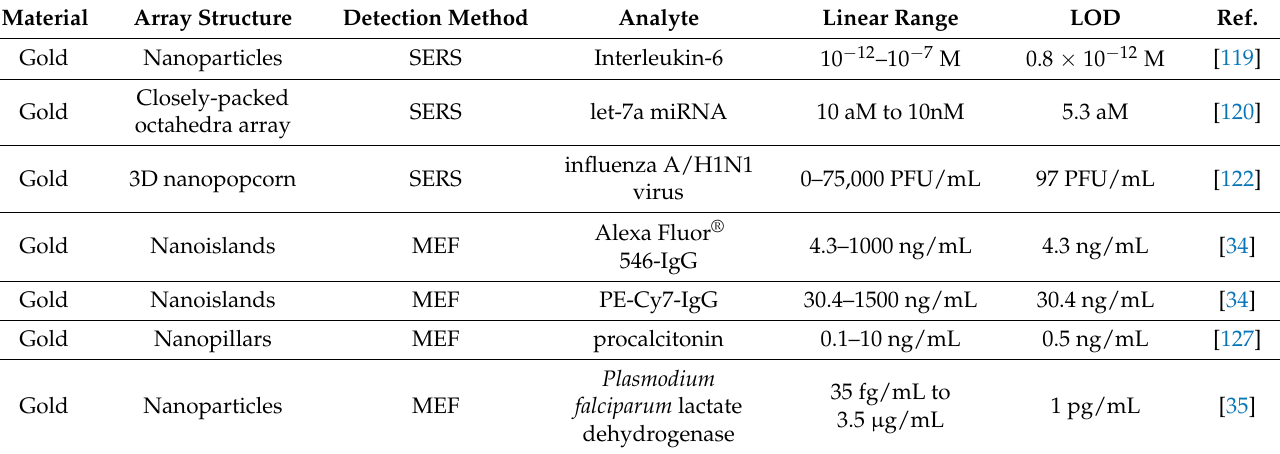
Table 3. Plasmonic nanoarrays for MEF- and SERS-based